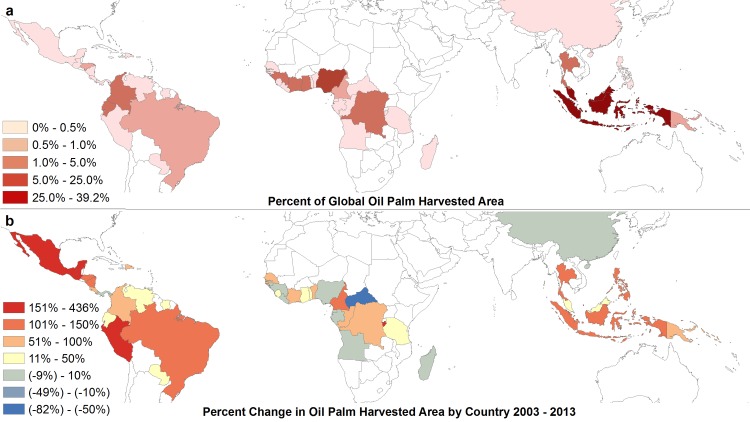
World production of palm oil.(a) Percent of FAO reported total global oil palm harvested area in 2013. (b) Percent changes in FAO reported oil palm harvested area by country from 2003–2013.